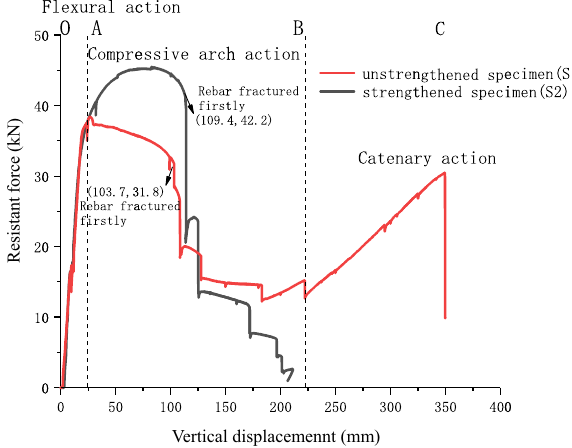
Figure 8: Resistance force versus the vertical displacement of the middle column of the